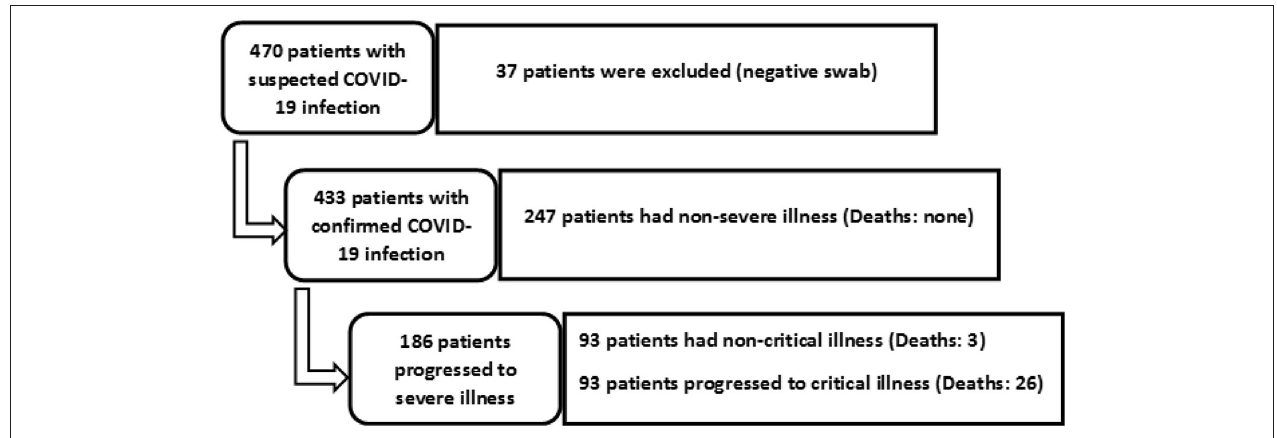
FIGURE 1 | Flow diagram of patient selection, categorization, and